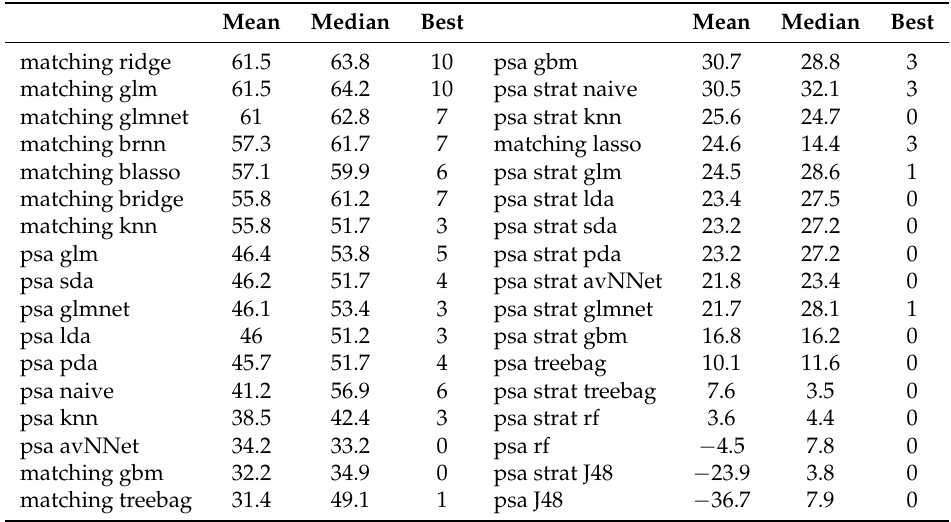
Table 1. Mean and median efficiency (%) of each estimator and the number of times it has been among the